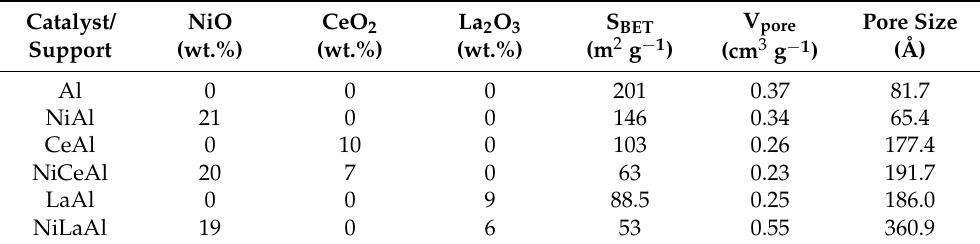
Table 1. Chemical composition of catalysts, BET surface area, pore volume, and mean pore size of supports and calcined